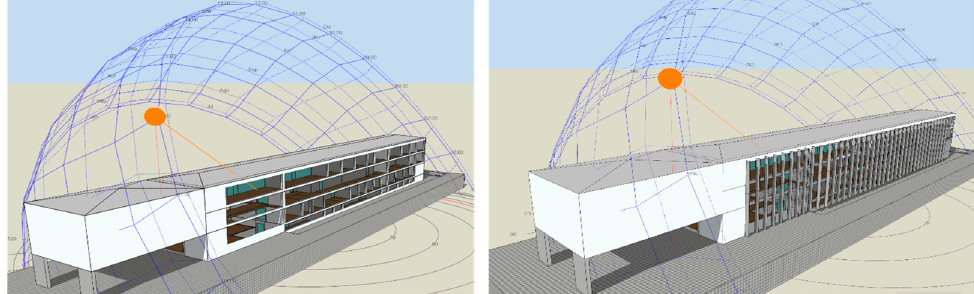
Figure 3. Rendered view of the façade; with ( right ) and without ( left ) solar control for the summer design day (Time: 13:00 h).